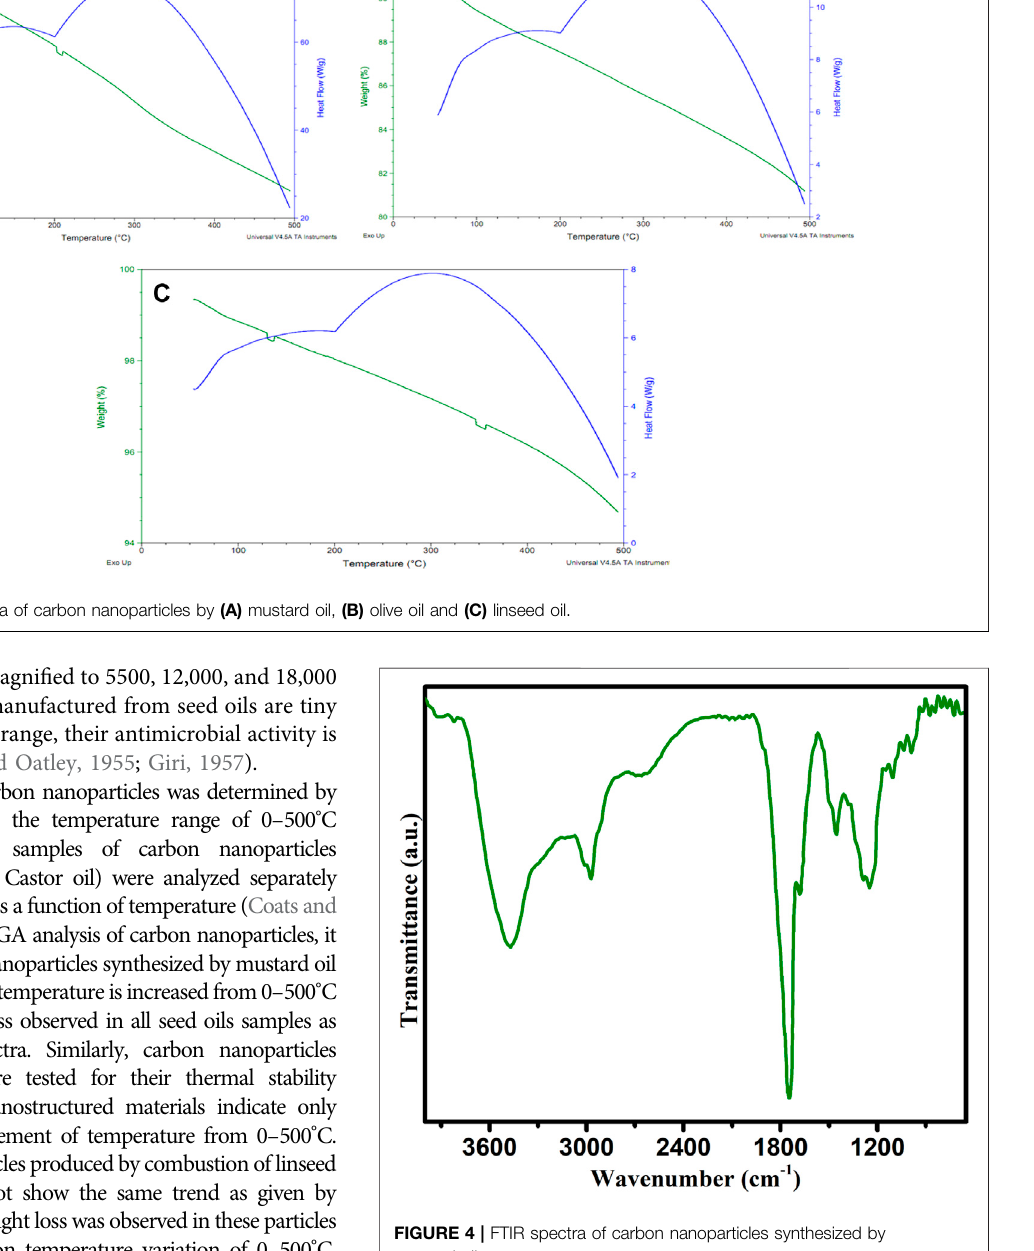
FIGURE 4 | FTIR spectra of carbon nanoparticles synthesized by mustard